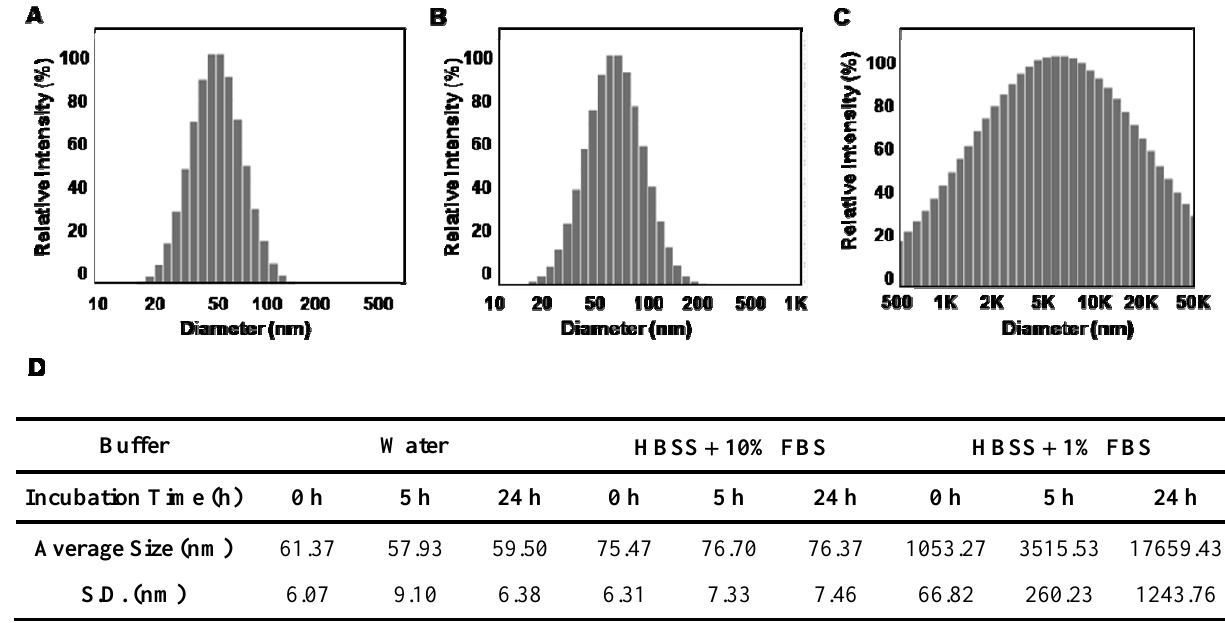
Figure 2. Stability of Hep-MION dispersions in physiological buffers. Dynamic light scattering histograms of Hep-MION in water (A) , HBSS with 10% FBS (B) , and HBSS with 1% FBS (C) after 24 h incubation at 37 ºC. Relative intensity values (%) are displayed with diameters (nm) in a log-scale. Particle size measurement of Hep MIONs (D) in three different batches in HBSS with 1% FBS, 10% FBS, or water after incubation at 37 ºC for 0, 5 and 24 h (n = 3). Sizes and distributions of nanoparticles in the various solutions (water, HBSS with 1% FBS, or HBSS with 10% FBS) were measured using NICOMP 380 ZLS DLS instrument after incubation at 37